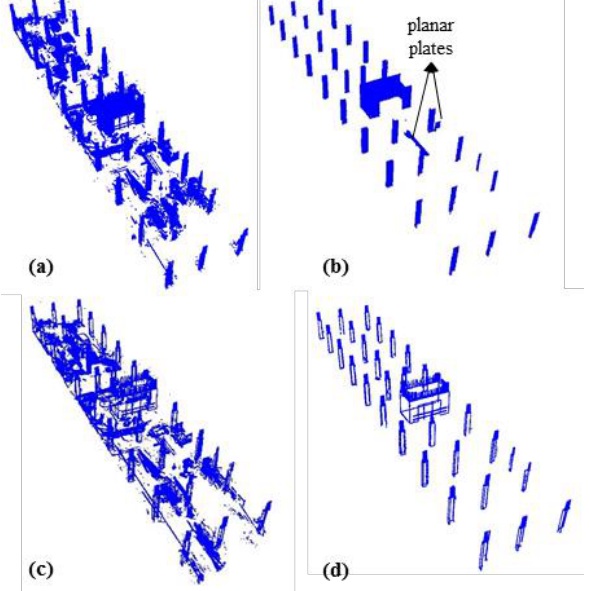
Figure 11. Robust planar and linear classification: a) after removing the floor; b) points classified as planar surfaces; c) points after removing the points classified as planes; d) points classified as linear